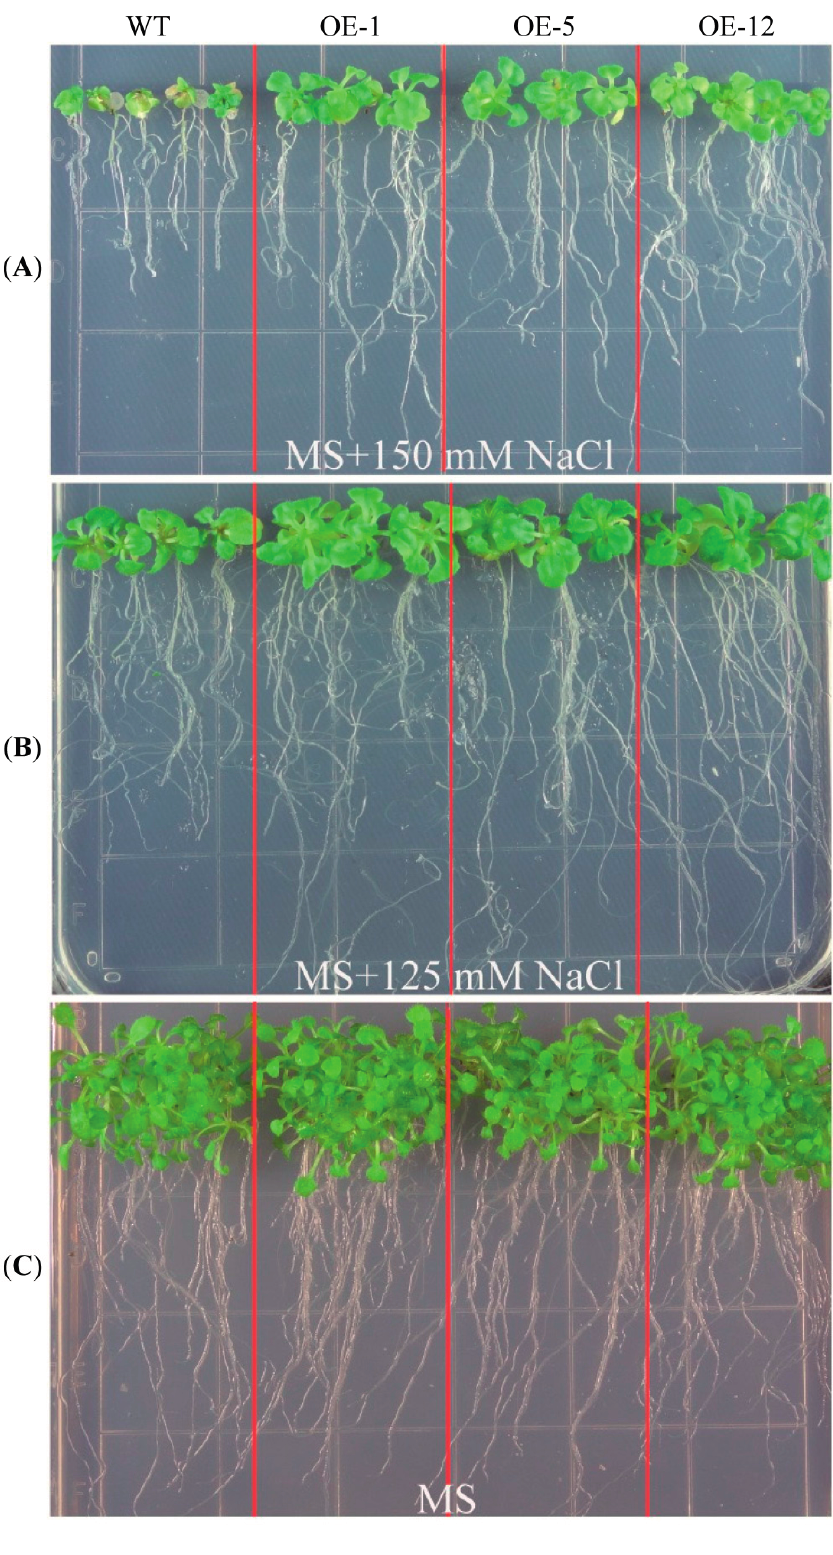
Figure 1. Performance of ZmCIPK21 -over-expressing transgenic plants under salt stress. ( A ) Phenotypic comparison of transgenic (OE-1, OE5, and OE-12) and wild-type (WT) plants under 150 mM salt stress; ( B ) Transgenic and WT plants under 125 mM salt stress; ( C ) Transgenic and WT plants grown on Murashige and Skoog (MS)